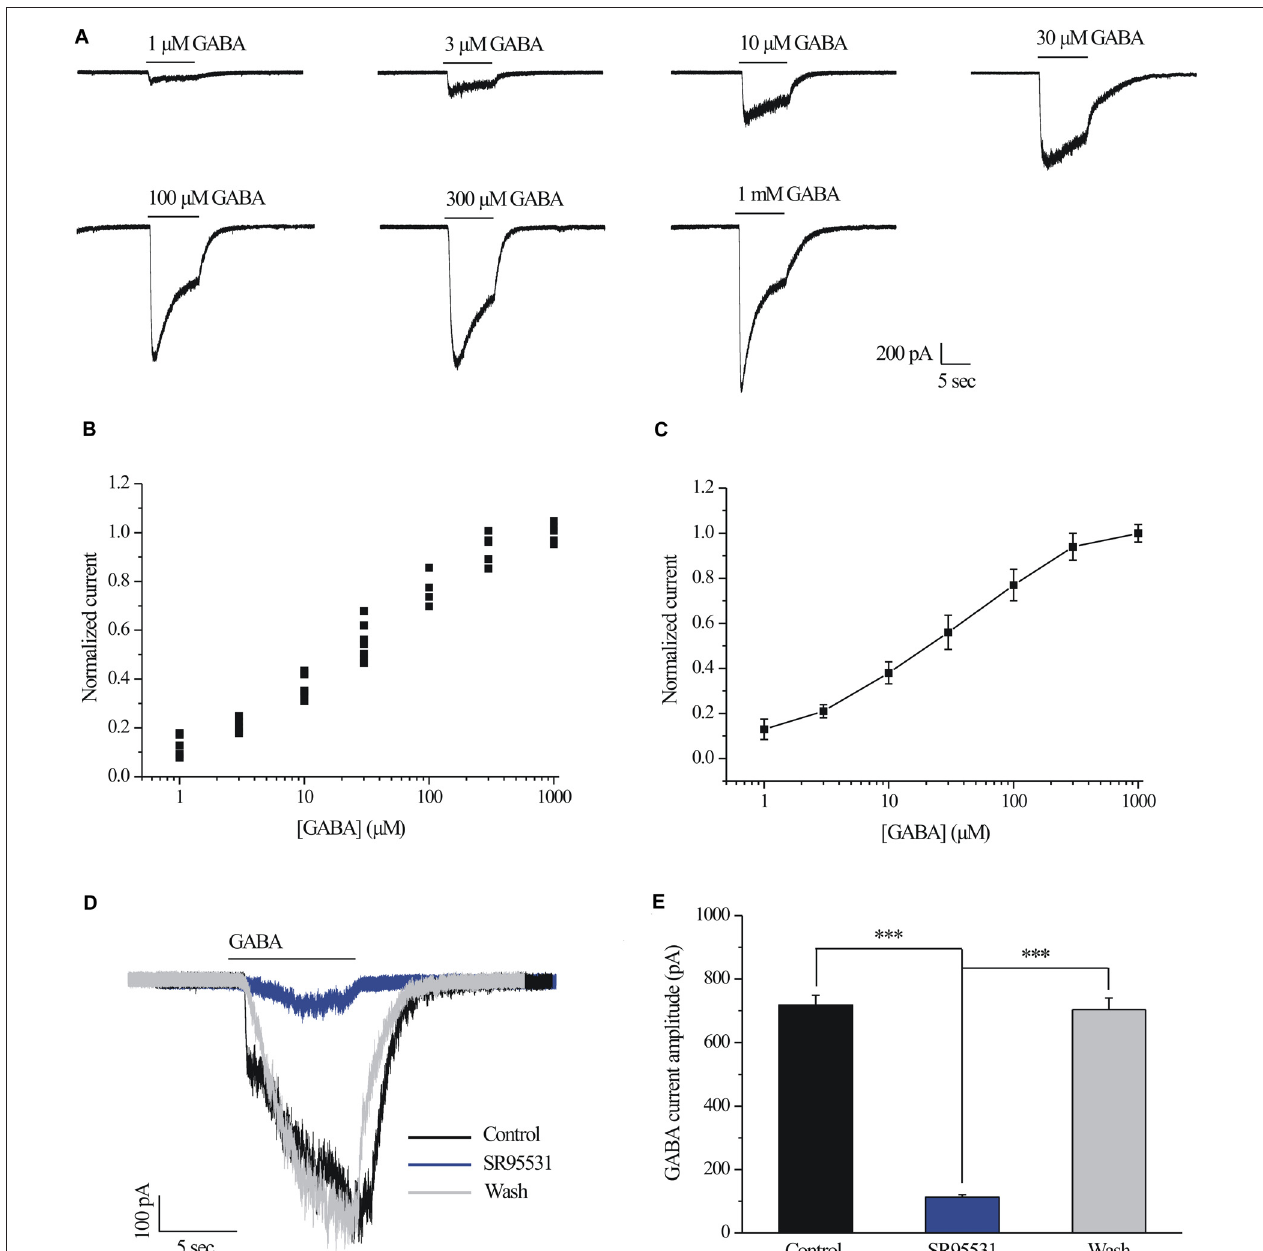
FIGURE 1 | γ -aminobutyric acid (GABA) dose-response relationship of retinal ganglion cells (RGCs). (A) The concentrations of GABA are indicated above the current traces. The bars delineate the beginning and duration of GABA application (8 s). Vertical calibration bar, 200 pA; horizontal calibration bar, 5 s. (B) Scatter plot showing the GABA concentration-response relationship of RGCs. The data were normalized to the maximal current obtained with 1 mM GABA. (C) The mean ± SE of the cells in (B) were plotted vs. the GABA concentration. The line represents the best fit of the data to a sigmoidal function. (D) Representative GABA-induced whole-cell currents in control, in the presence of 10 µ M SR95531, and after washing out SR95531. Vertical calibration bar, 100 pA; horizontal calibration bar, 5 s. Control and washout responses without SR95531 were measured at the beginning and end of each experiment, respectively. (E) Summarized data of the amplitude of GABA-evoked currents ( n = 11). ∗∗∗ p < 0.001 (one-way analysis of variance). Holding potential was − 70 mV. The results are expressed as the mean ± standard error.